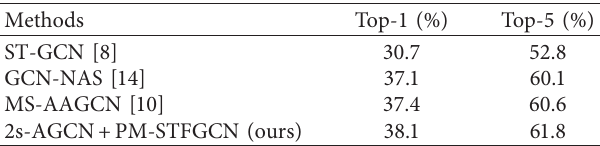
Table 4: Comparison with Kinetics-Skeleton dataset with state-of- the-art schemes.